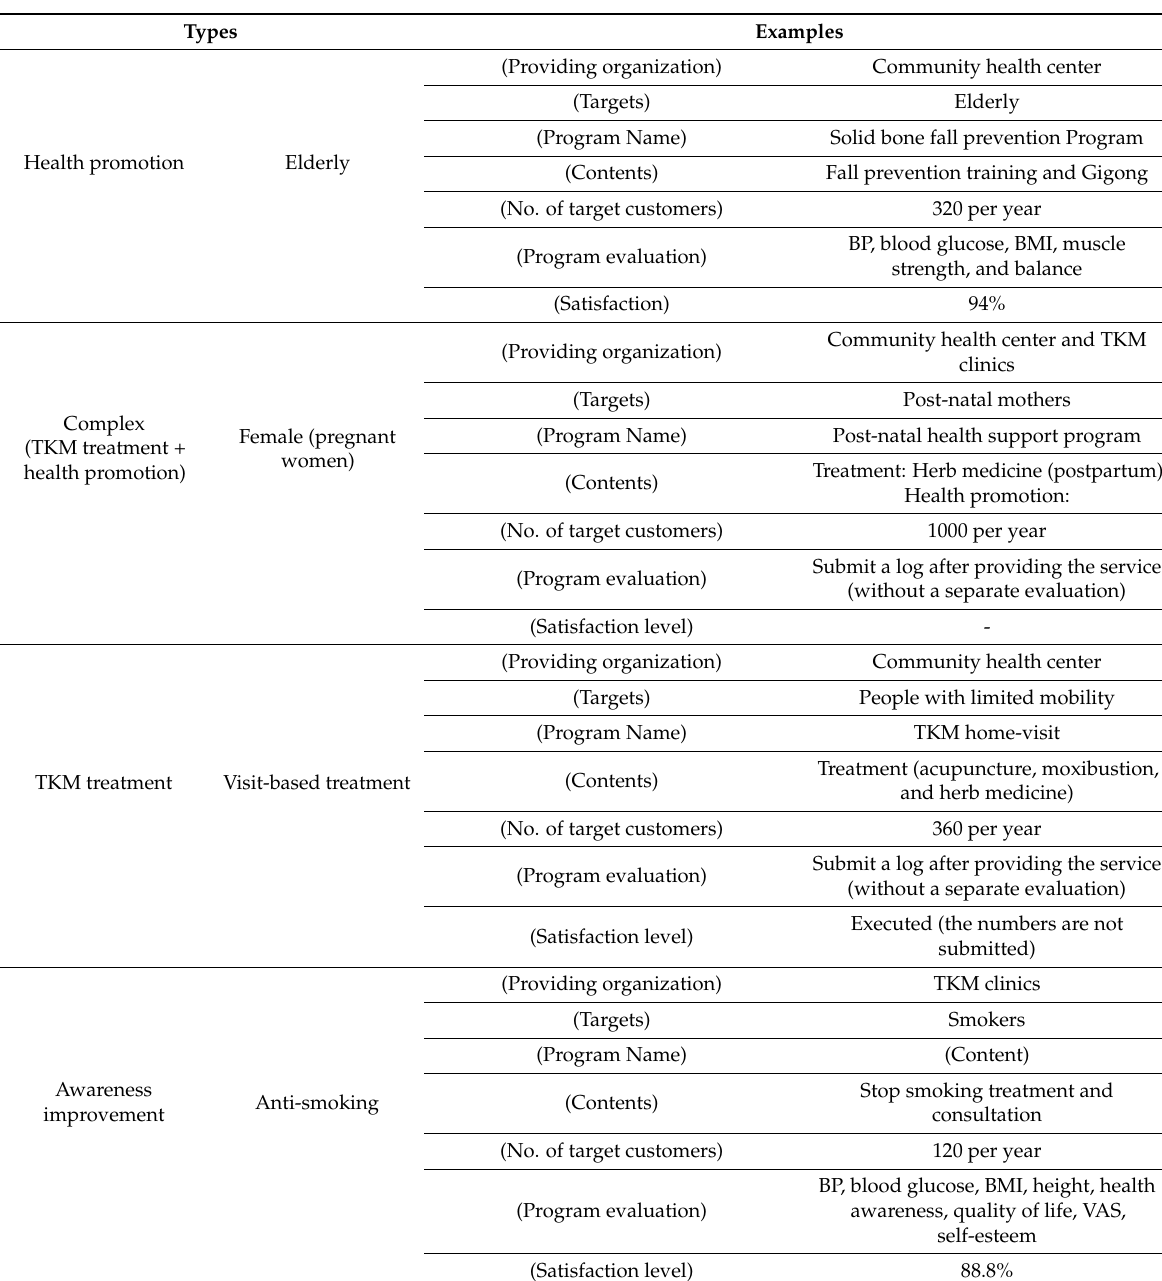
Table 3. Key examples of TKM services provided by